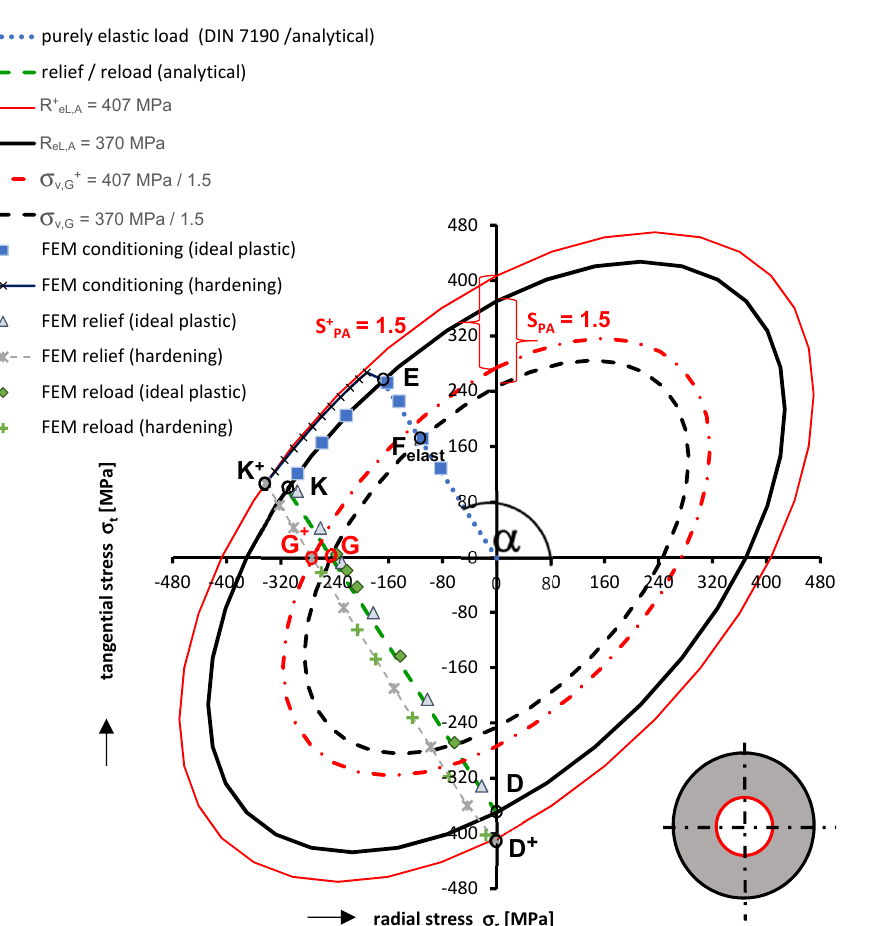
Figure 3. Stress states (analytically and numerically determined) at any point of the inner diameter (marked in red) of an outer part with Q A = 0.45 in the principal stress plane, based on the von Mises yield criterion during conditioning.